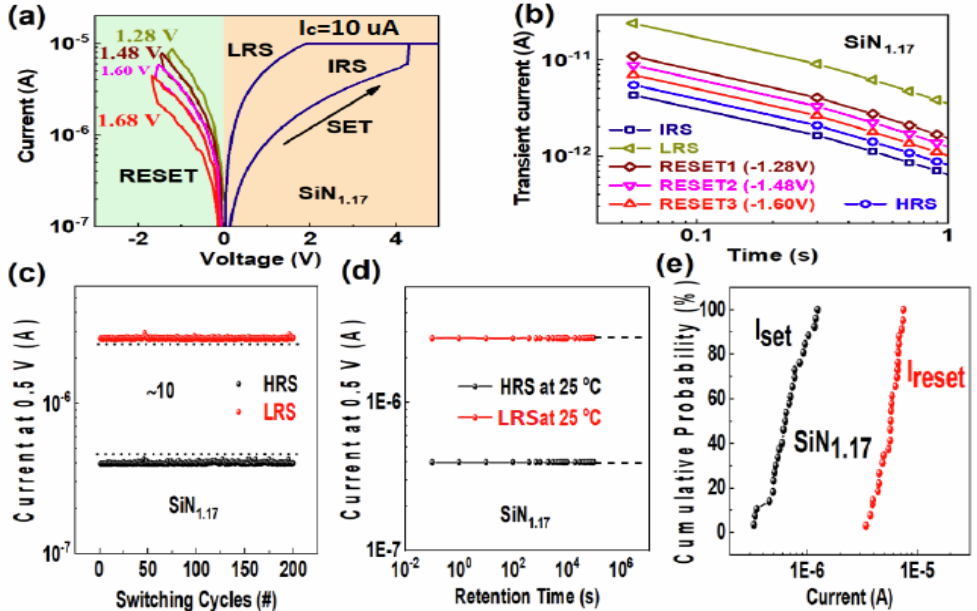
Figure 3. ( a–b ) Multilevel resistive switching I-V curves and the corresponding transient current of a-SiN 1.17 :H-based RRAM device in different resistance states. ( c ) The endurance characteristics of the Al/a-SiN x :H/P + -Si device after 200 consecutive cycles. ( d ) The retention properties of the Al/a- SiN x :H/P + -Si device at room temperature. ( e ) The statistical distributions of SET/RESET currents of 26 devices.